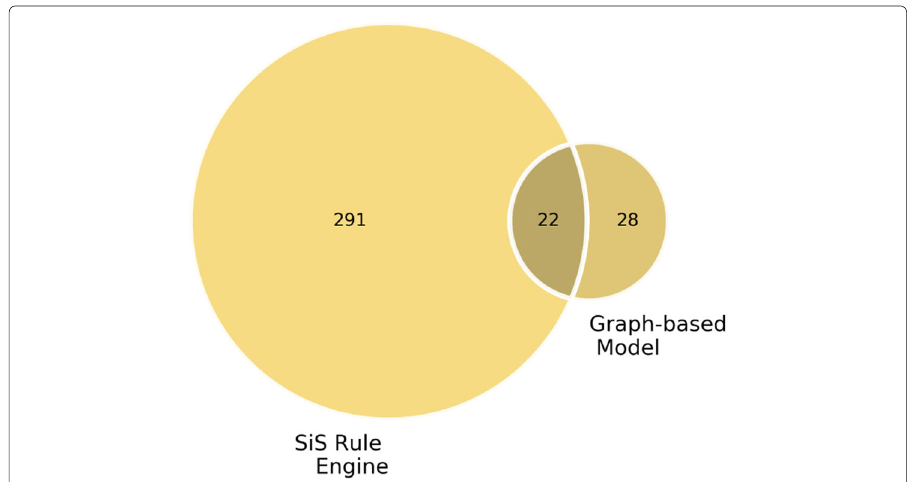
Fig. 11 Distribution of “medium” legitimacy label. The medium legitimacy label corresponds to a transaction that is not trusted but doesn’t show fraudulent behavior